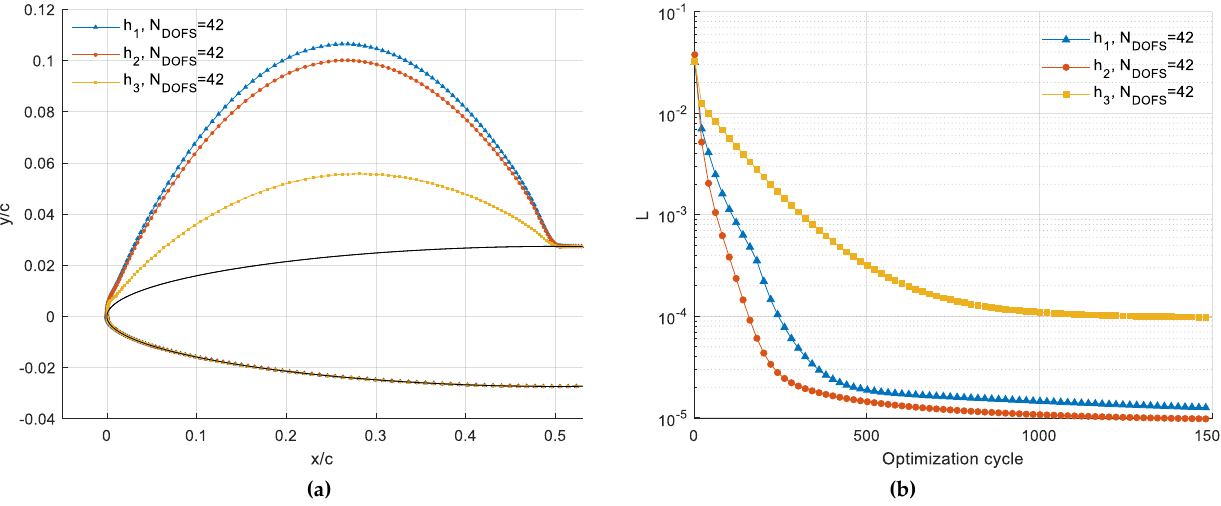
Figure 6. Present method for NACA16 – 006 at a = 6deg for N = 42 DOFS. ( a ) Initial guesses h1, h2, and h3 for the cavity shape ( b ) Cost functional evolution for each initial guess as to the optimization cycles progress.